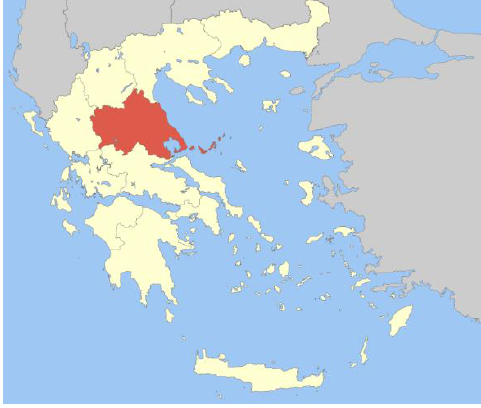
Figure 3. Map of the region of the case study.